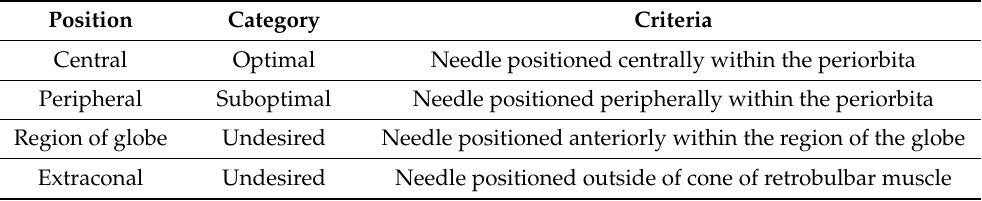
Table 1. Scoring system for needle positioning at Computed Tomography (CT). Position Category Criteria Central Optimal Needle positioned centrally within the periorbita Peripheral Suboptimal Needle positioned peripherally within the periorbita Region of globe Undesired Needle positioned anteriorly within the region of the globe Extraconal Undesired Needle positioned outside of cone of retrobulbar